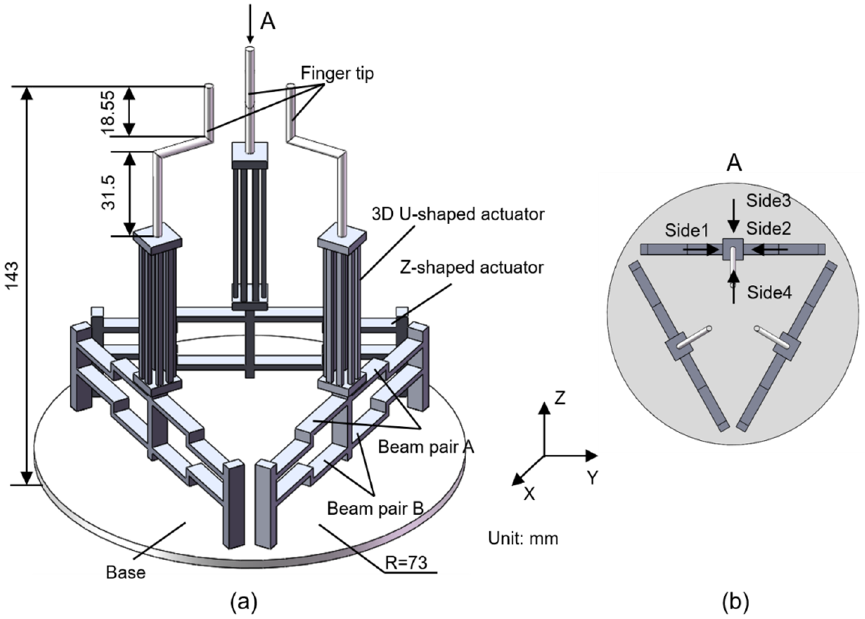
Figure 1. Structure of the 3D electrothermal microgripper: ( a ) general view, ( b ) top view.